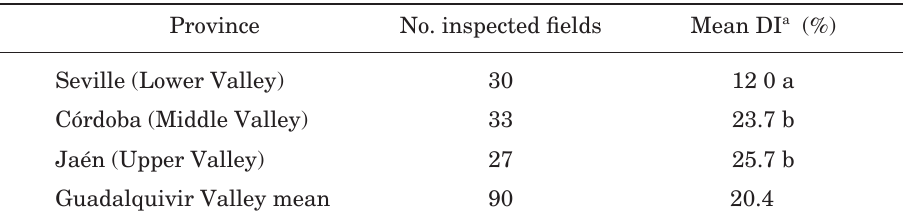
Table 1. Incidence of Verticillium wilt of olive in some orchards in three provinces of the Guadalquivir Valley (sou- thern